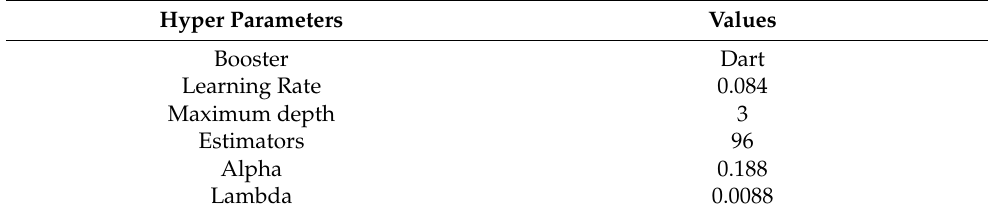
Table 3. Optimized Hyperparameters for